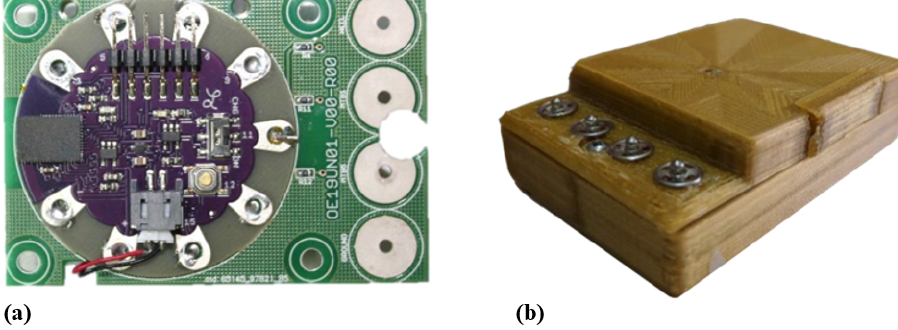
Figure 3. SWEET Sock ElectronicUnit: ( a ) internal electronic unit; ( b ) complete unit external